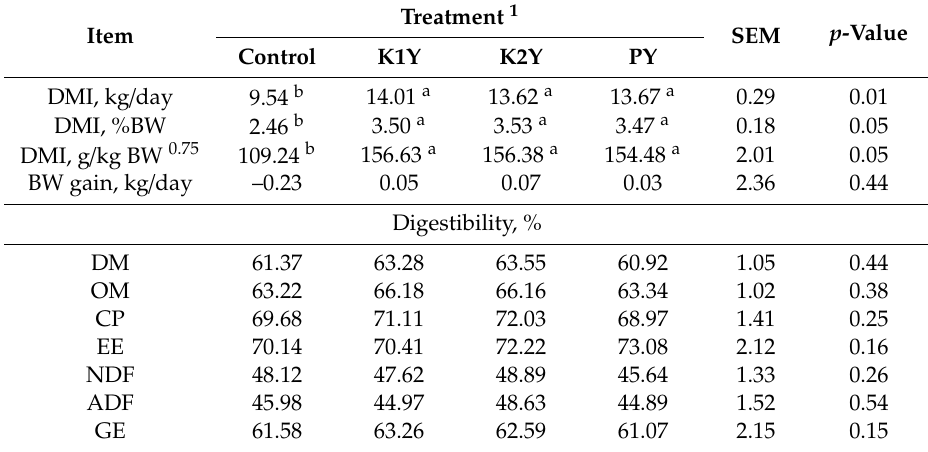
Table 3. Dry matter intake (DMI), body weight (BW) change and nutrient digestibility of cows fed TMR supplemented with aflatoxin-detoxifying